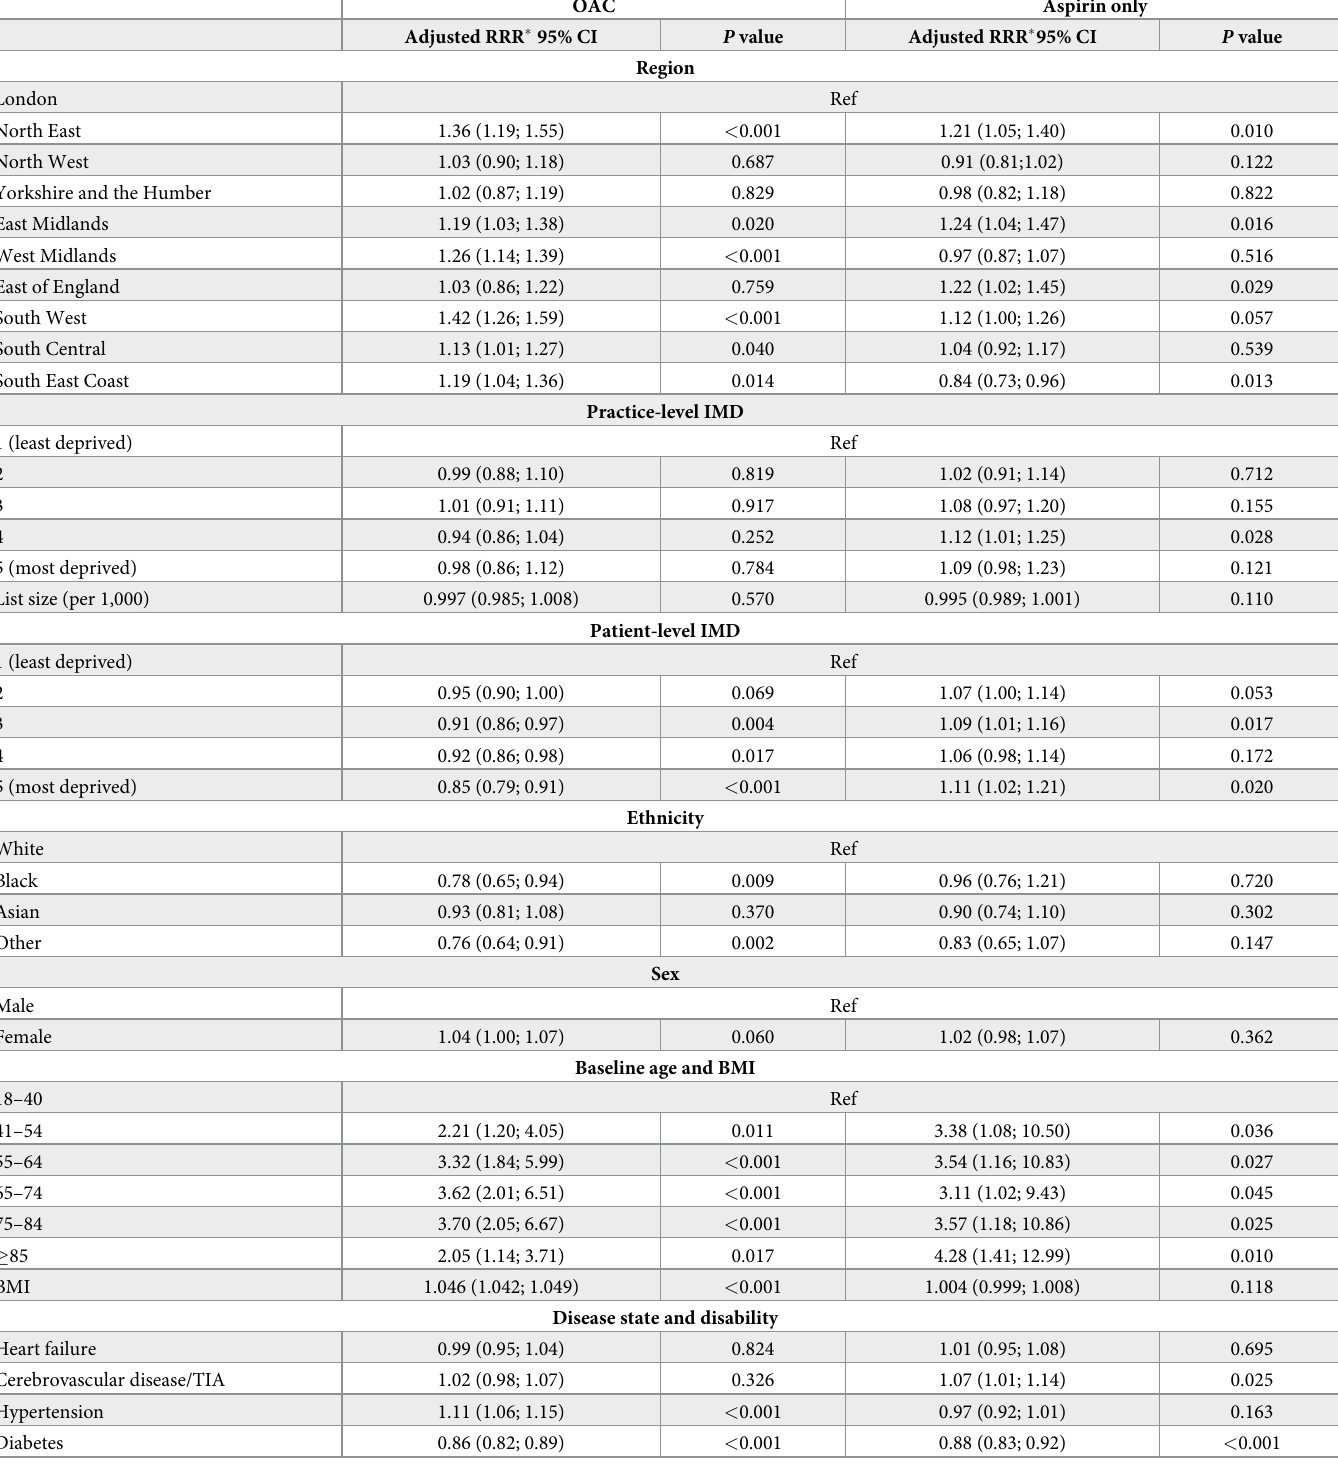
Table 3. Results of multivariable analysis evaluating factors associated prescribing of OAC or aspirin only vs. no treatment (reference group) in patients recom- mended to take